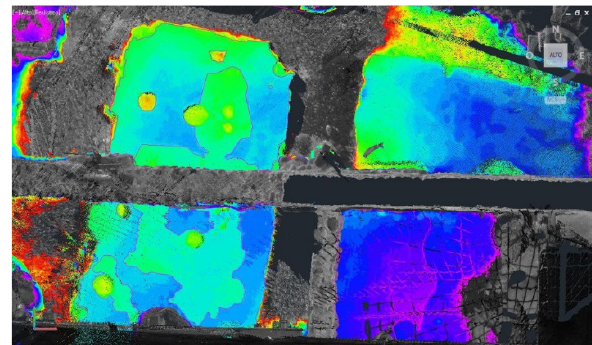
Figure 5: Different colors on the point-cloud according to elevation. From the colormap, it is possible to recognize the borders of the mosaics (the thickness of the mosaic is about 5 mm).